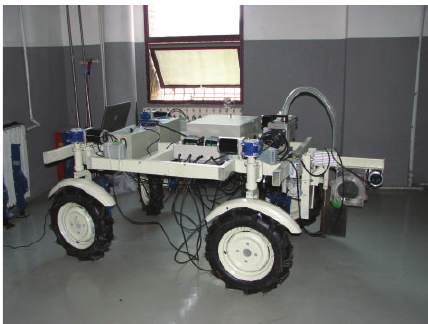
Figure 1: Wheat precision seeding